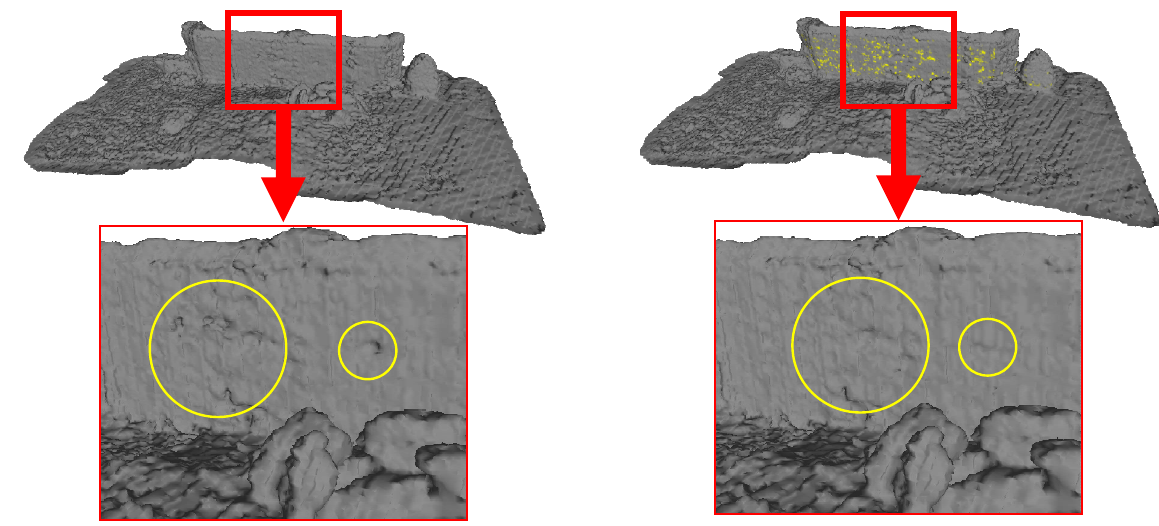
Figure 5. Comparison of mesh